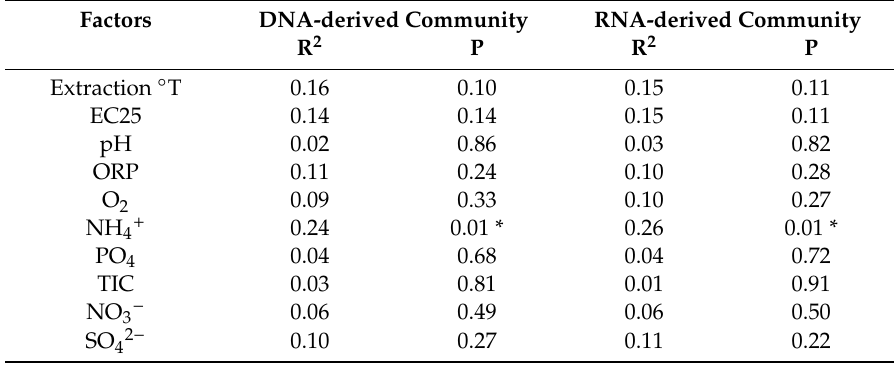
Goodness-of-fit statistics (R 2 ) for factors fitted to the three-dimensional non-metric multidimensional scaling (3D-NMDS) ordination of DNA- and RNA-derived fungal community composition based on presence / absence data and Jaccard distance measure. 275